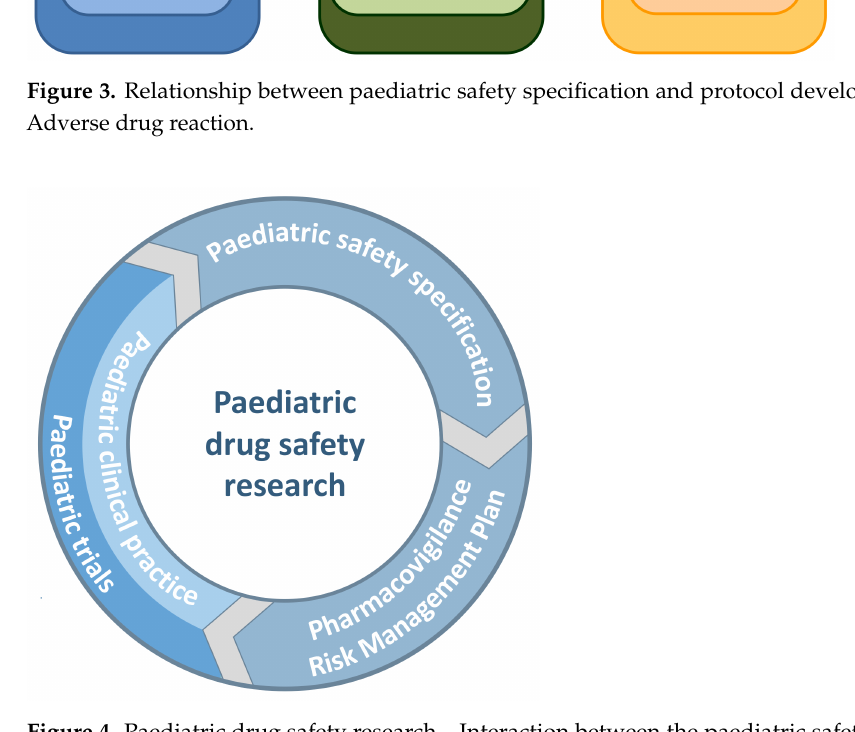
Figure 4. Paediatric drug safety research—Interaction between the paediatric safety specification, pharmacovigilance, risk management plan, clinical studies, and clinical